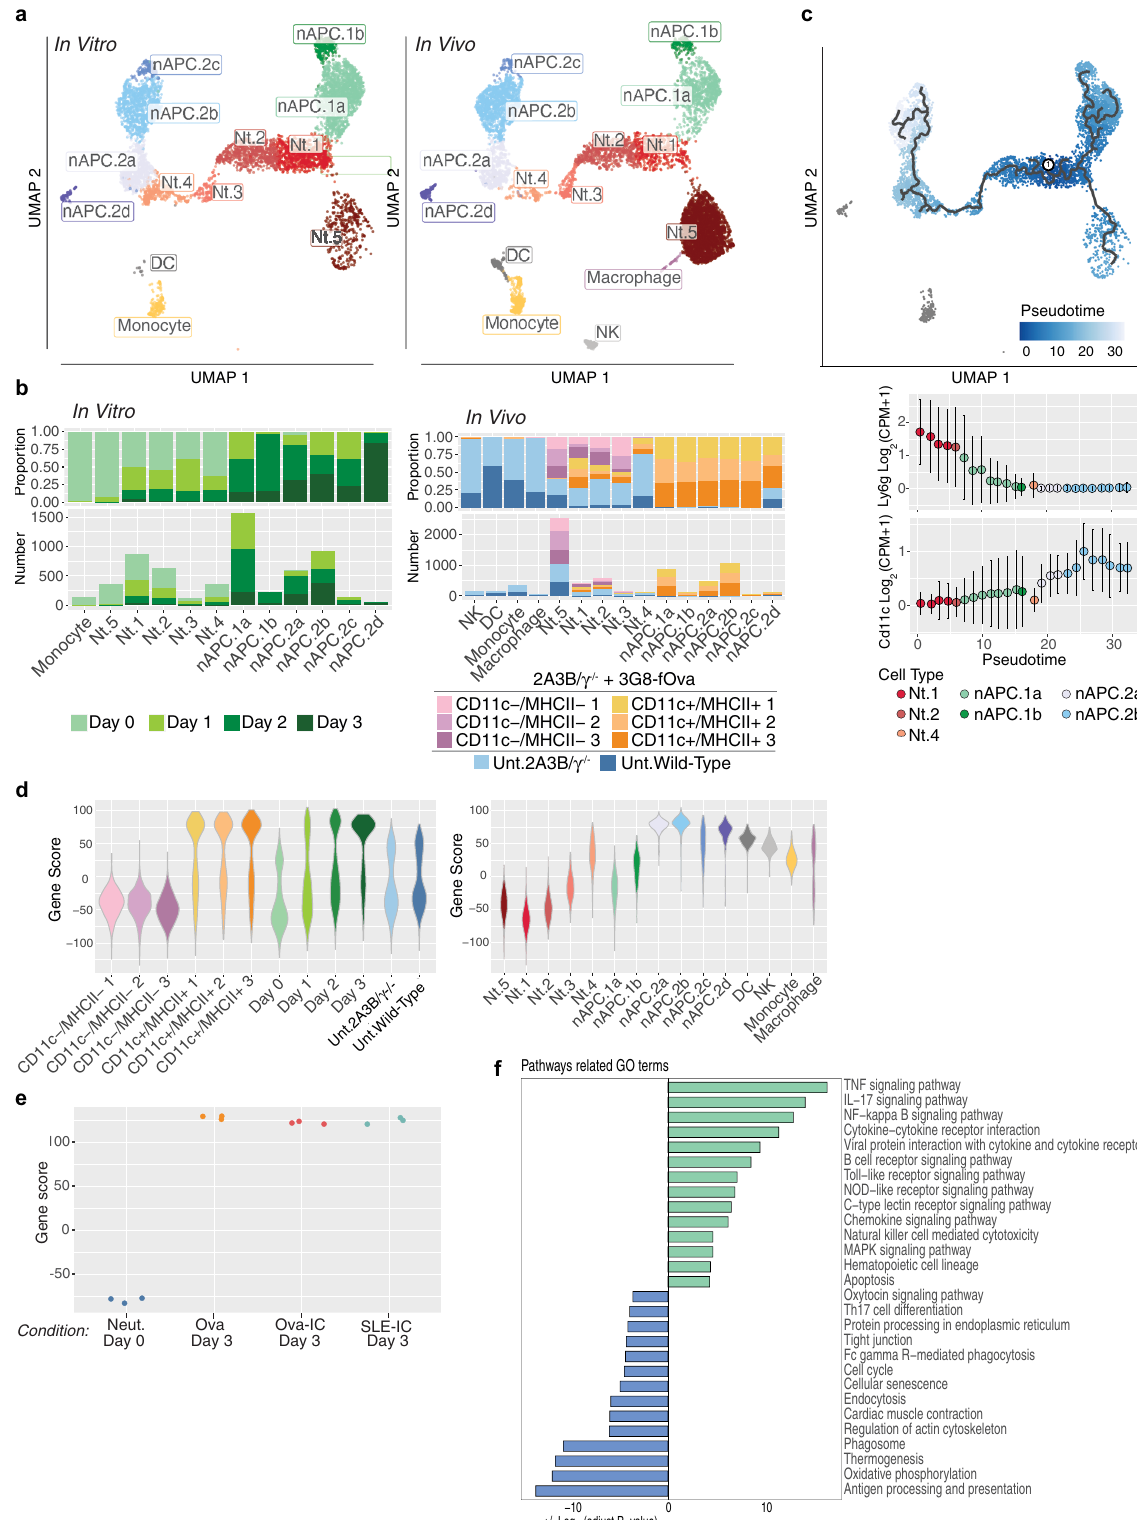
acquisition of immunogenic functions, a fruitful area for future studies. Endocytosis of the GPI-linked Fc γ RIIIB following 3G8-fOva engagement preceded and was essential for nAPC conversion, consistent with evidence that endosomes are signaling hubs